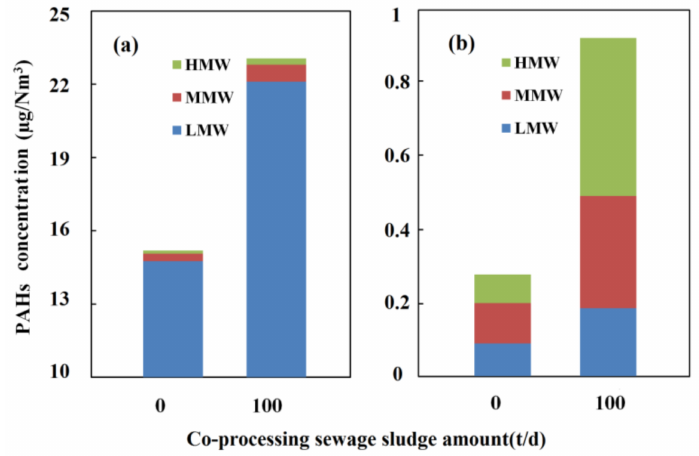
Figure 2. The low molecular weight (LMW) PAHs, middle molecular weight (MMW) PAHs and high molecular weight (HMW) PAHs distributions in gas phase ( a ) and particle phase ( b ) of the flue